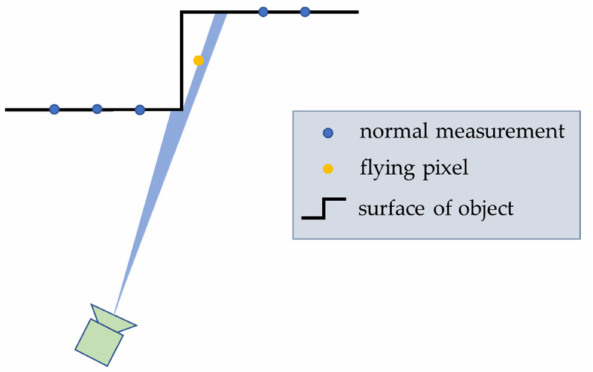
Figure 3. Schematic of flying